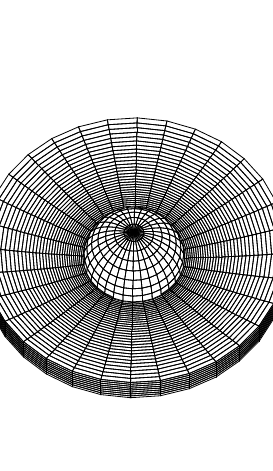
Fig. 1. Model configuration of RS Oph. The cool component (right in the figure) is a red giant underfilling its inner critical Roche lobe (about 50% in radius). The hemisphere is heated up by the hot component (1 : 35 M ⊙ WD, left in the figure). The surface of the accretion disk is also heated up by the hot component. total brightness of RS Oph (thin solid line labelled ‘blackbody’), i.e., WD + disk